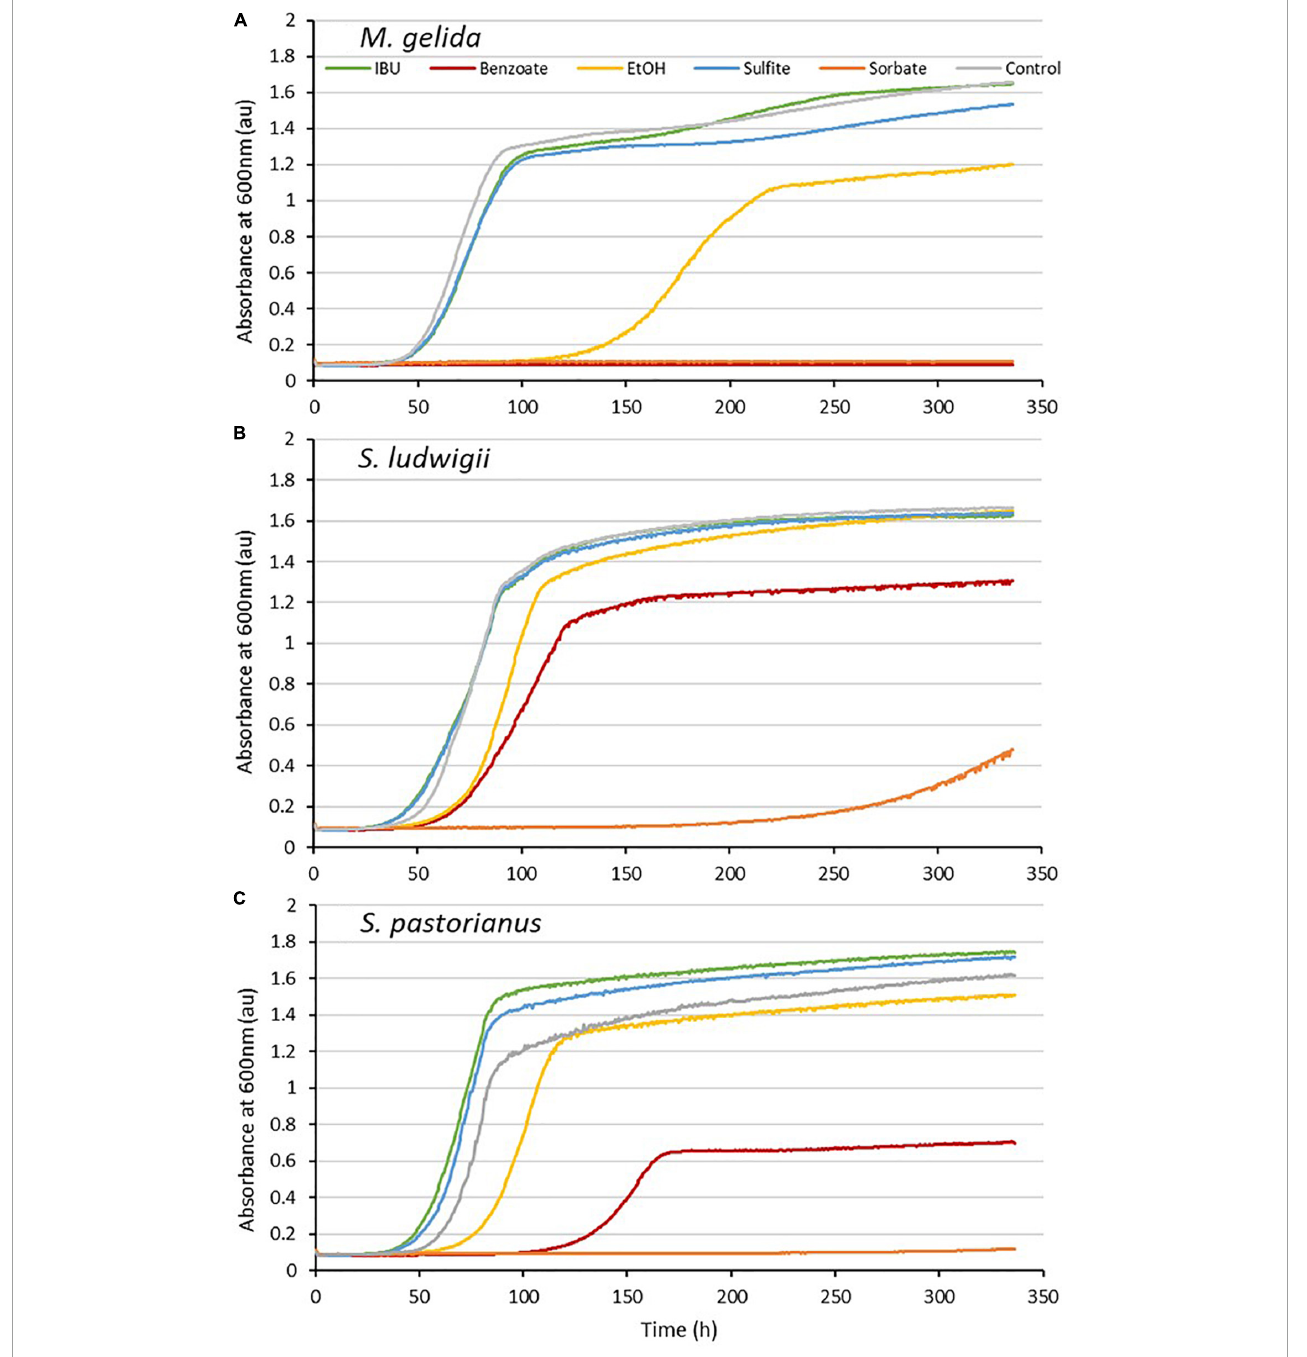
FIGURE4 Growth curves with IsoHop (IBU), benzoate, ethanol, sulfite, sorbate and control for Mrakia gelida (A) , Saccharomycodes ludwigii (B) , and S. pastorianus (C) . The x-axis indicates time (h), and the y-axis shows the yeast absorbance at 600 nm